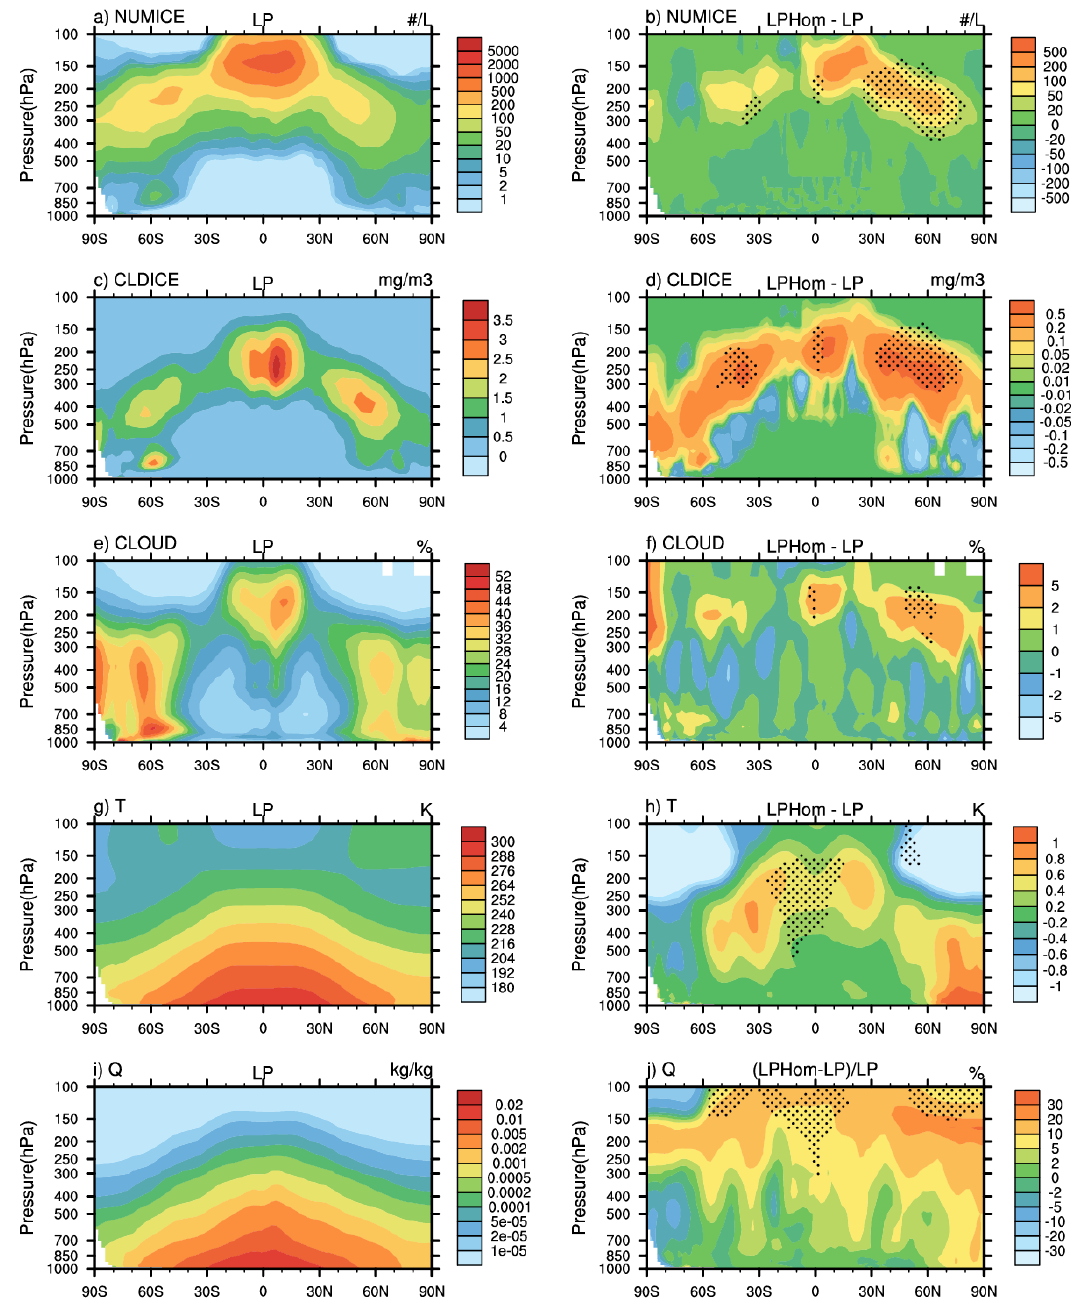
Fig. 8. Latitude-pressure cross sections of annual mean Ni (grid-box average), IWC (grid-box average), cloud cover, temperature, and specific humidity from combined ice nucleation simulation (left) and differences of these variables between pure homogeneous and combined nucleation simulations (right) for the LP05 parameterization in CAM5. Differences significant at the 90% level of the Student’s t-test are depicted by dots.